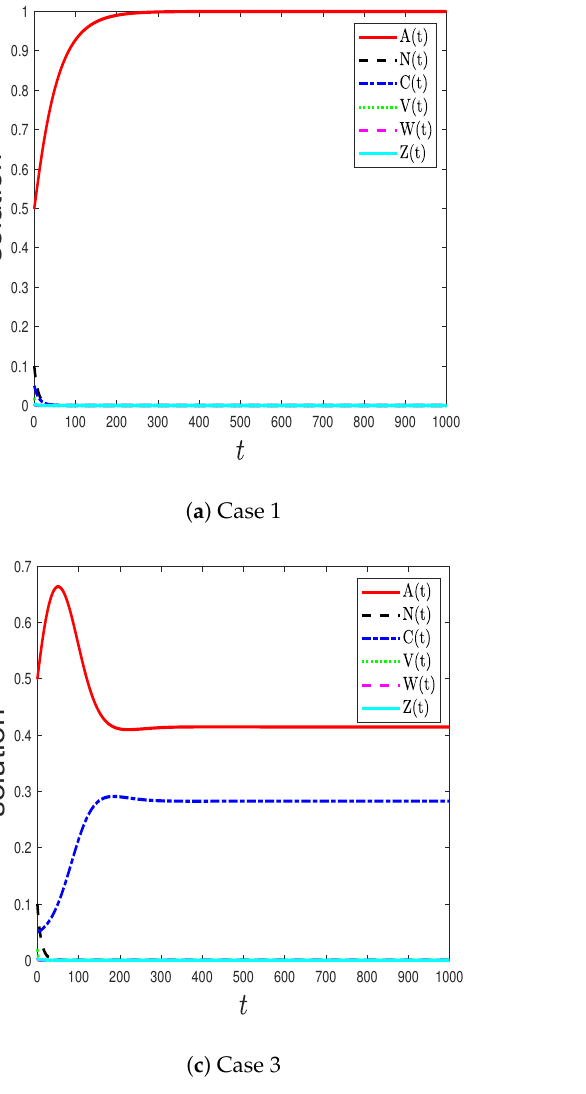
Figure 1. The numerical simulations of system (1) for cases 1–4. The figures show the global stability of ( a ) the trivial steady state E 0 : η 1 = 0.03, η 2 = 0.03, η 4 = 0.03, η 5 = 0.3, κ 1 = 0.1, κ 2 = 0.08, κ 3 = 0.5, κ 4 = 0.9, κ 5 = 0.07, ( b ) the healthy-cell steady state E 1 : η 1 = 0.1, η 2 = 0.03, η 4 = 0.03, η 5 = 0.3, κ 1 = 0.02, κ 2 = 0.08, κ 3 = 0.5, κ 4 = 0.9, κ 5 = 0.07, ( c ) the cancer-cell steady state E 2 : η 1 = 0.03, η 2 = 0.1, η 4 = 0.03, η 5 = 0.3, κ 1 = 0.1, κ 2 = 0.01, κ 3 = 0.5, κ 4 = 0.9, κ 5 = 0.07, and ( d ) the infection steady state E 3 : η 1 = 0.3, η 2 = 0.03, η 4 = 0.03, η 5 = 0.3, κ 1 = 0.02, κ 2 = 0.08, κ 3 = 0.01, κ 4 = 0.9, κ 5 =